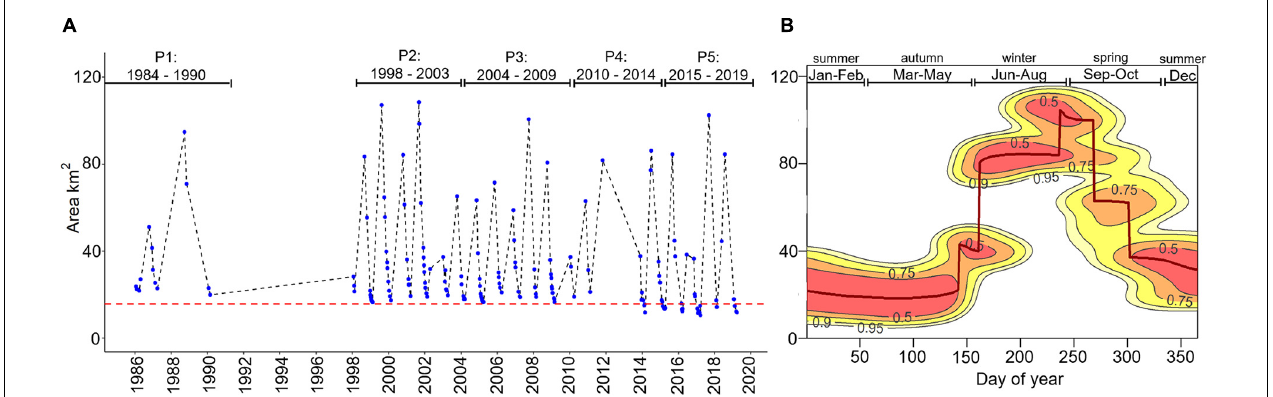
FIGURE 3 | Total snow cover time series 1986–2019 (A) and seasonality (B) of the Mocho Choshuenco volcano based on 159 cloud-free Landsat images. Seasonality of total snow cover area was calculated using Gaussian kernel density estimations of the snow cover along the year based on all historical records. Red color in panel (B) indicates high frequency of a given snow cover at different days of the year and yellow color lower frequencies of snow cover areas. Summer is very stable and the area covered by snow is about 20 km 2 . The end of winter and the start of spring are the periods with larger snow cover, approximately 100 km 2 . Then the snow cover decreases gradually in spring till the basal 20 km 2 of snow cover in summer. Note that from 2014 onward the lowest snow cover area is lower than the basal 20 km 2 (red dotted line).